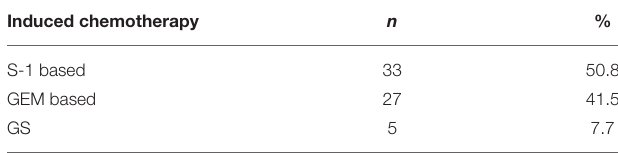
TABLE 2 | Treatment: induced chemotherapy ( n = 65).